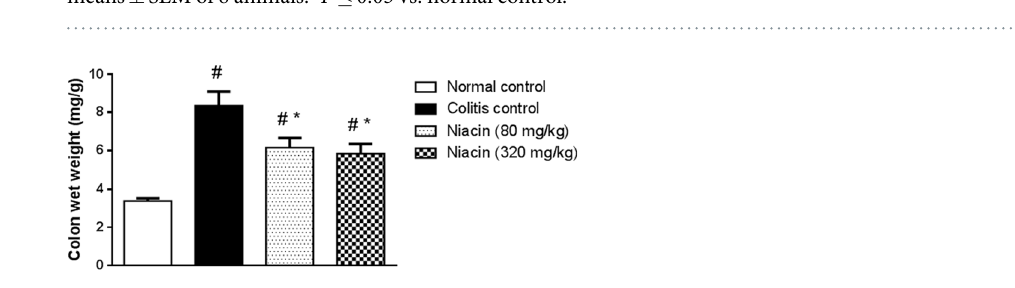
Figure 1. Effect of pretreatment with niacin on the increase in body weight of animals with iodoacetamide- induced colitis measured from the time of induction of colitis until sacrifice. Data are expressed as means ± SEM of 8 animals. # P ≤ 0.05 vs. normal control.